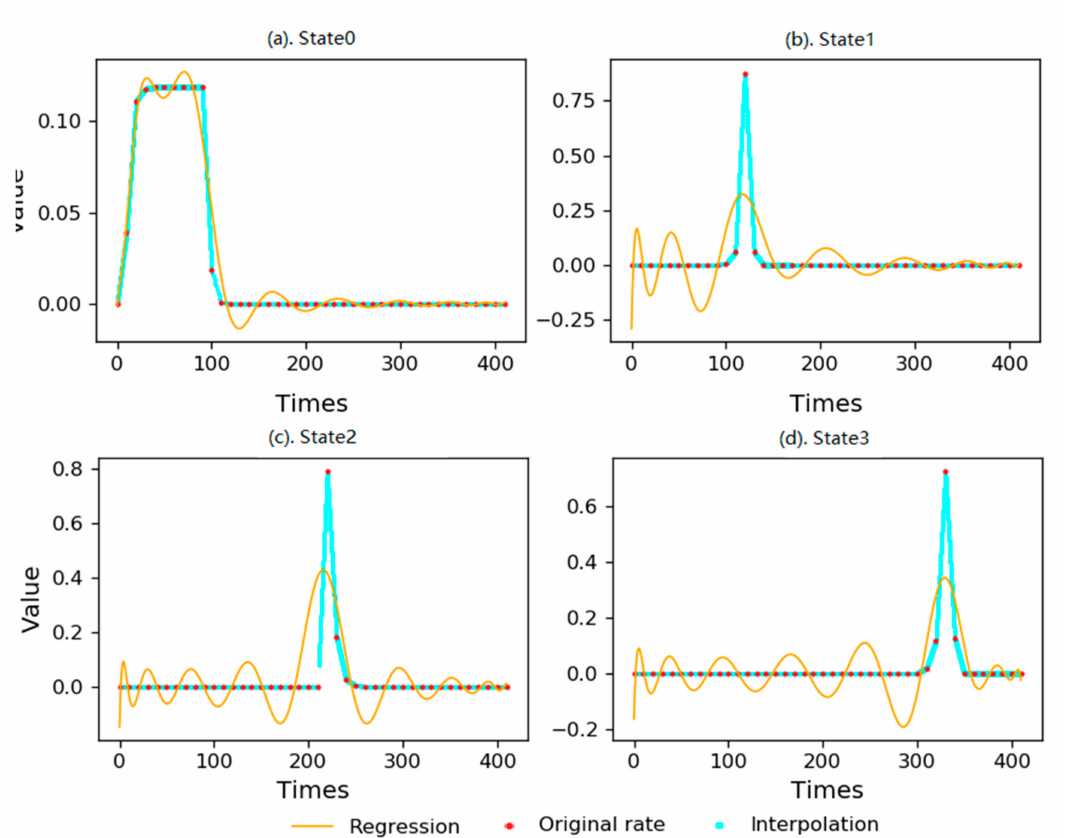
Figure 5. Swarm intelligence algorithm iteration process.